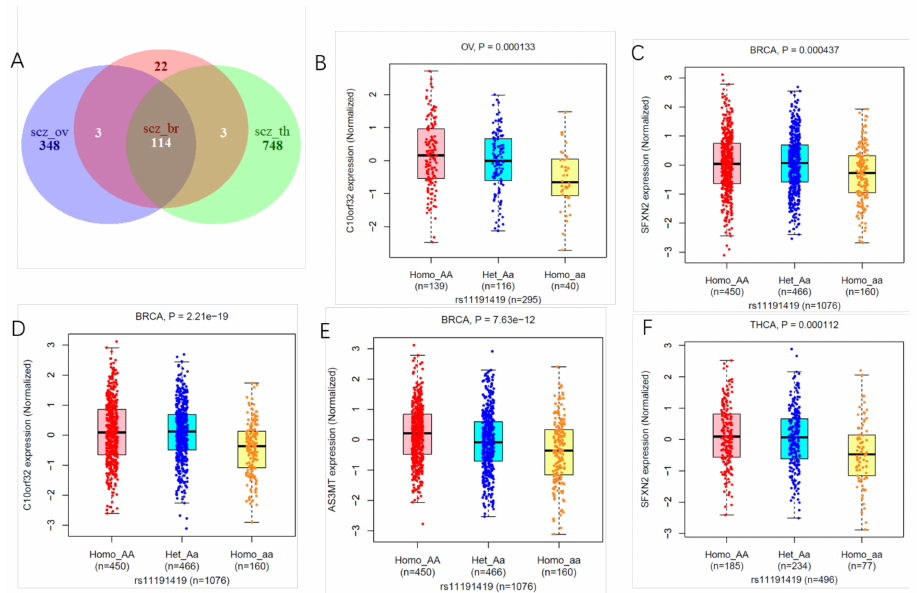
Figure 3. Shared variants regulated different genes expression in three tumors. Venn diagram showing ( A ) Number of specific and shared variants of three study cohorts; ( B ) Number of specific and shared genes of three study cohorts; ( B – F ) boxplot showing rs11191419 with eQTL genes expression in different cancers.scz_br: the common variants in schizophrenia and breast cancer; scz_ov: the common variants in schizophrenia and ovarian cancer; scz_th: the common variants in schizophrenia and thyroid cancer; OV: ovarian cancer; BRCA: breast cancer; THCA: thyroid